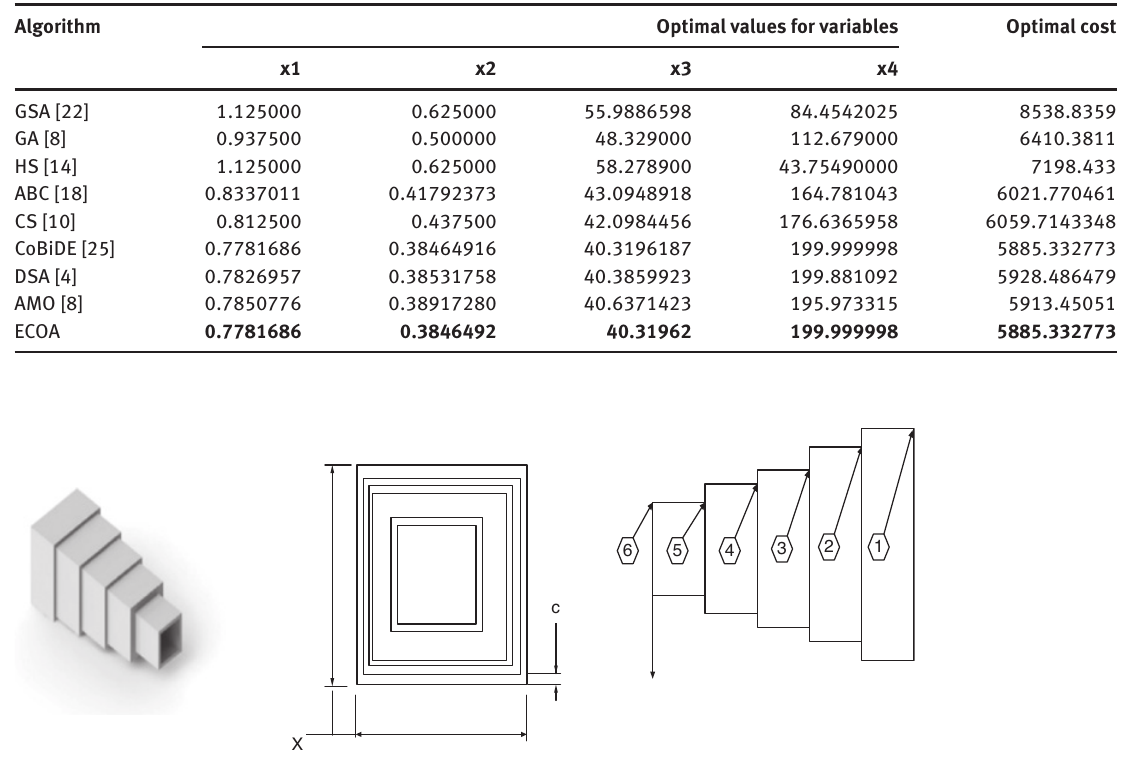
Figure 48: Cantilever Beam Design